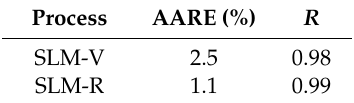
Figure 7. Comparison between the predicted stresses by J–C model and experimental measurements: ( a ) SLM-R, ( b ) SLM-V. Table 3. The calculated values of ARRE and R for the J–C model.